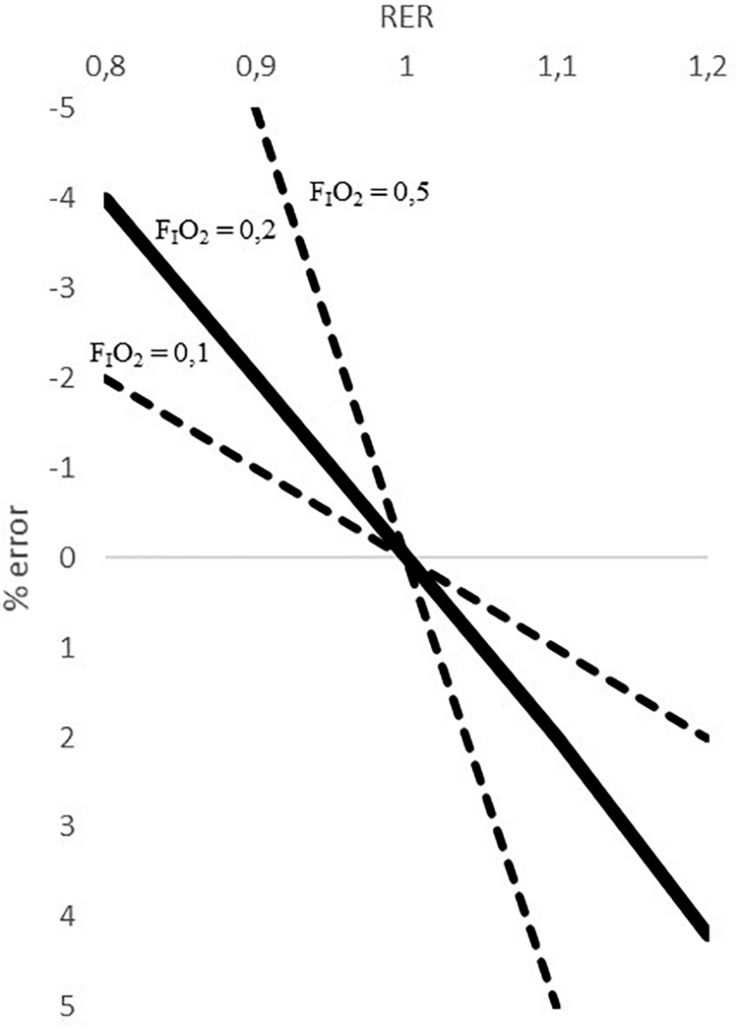
Error involved when oxygen consumption is estimated by Eq. 3 modified from Otis (1964).